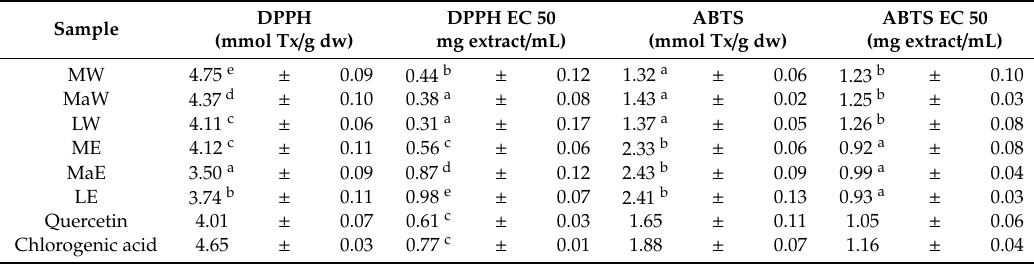
Table 4. Antioxidant activity of water and ethanol extracts of three hop varieties (Magnum, Marynka, Lubelski) by methods of ability to scavenge radicals in test with DPPH · and ABTS + .